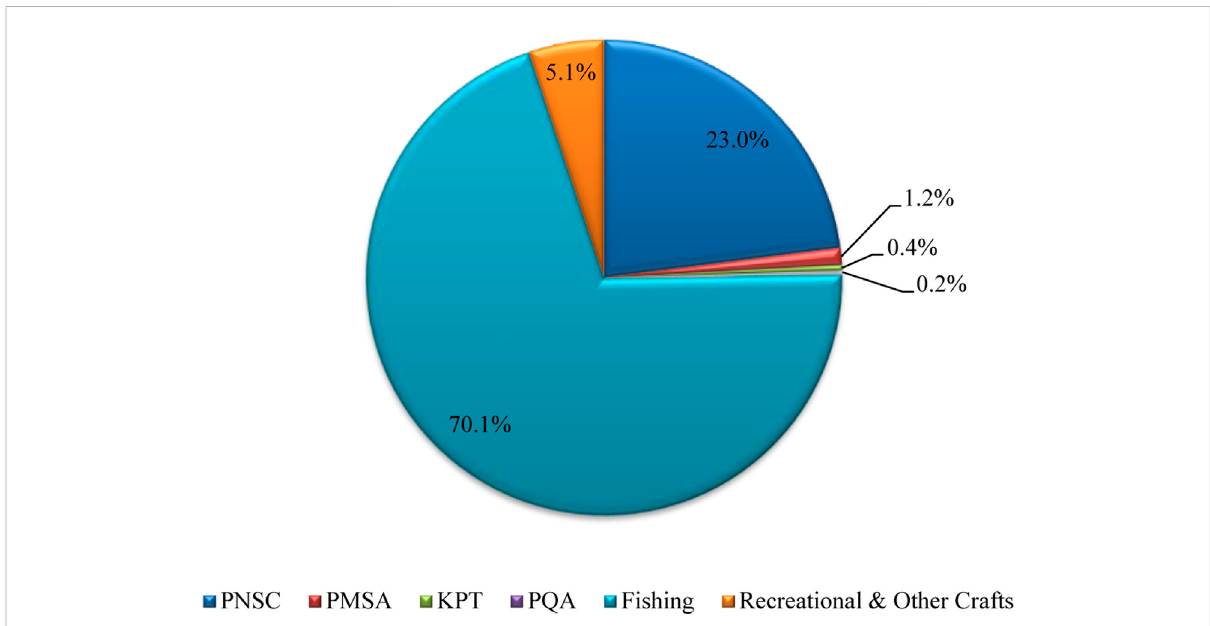
FIGURE 1 Share of GHG emissions (CO 2 e) from maritime vessels (A) PNSC: Pakistan National Shipping Corporation (B) PMSA: Pakistan Maritime Security Agency (C) KPT: Karachi Port Trust (D) PQA: Port Qasim Authority (E) Fishing vessels (F) Recreational and other crafts such as skiff boats, passenger boats, water and fuel carrying boats.